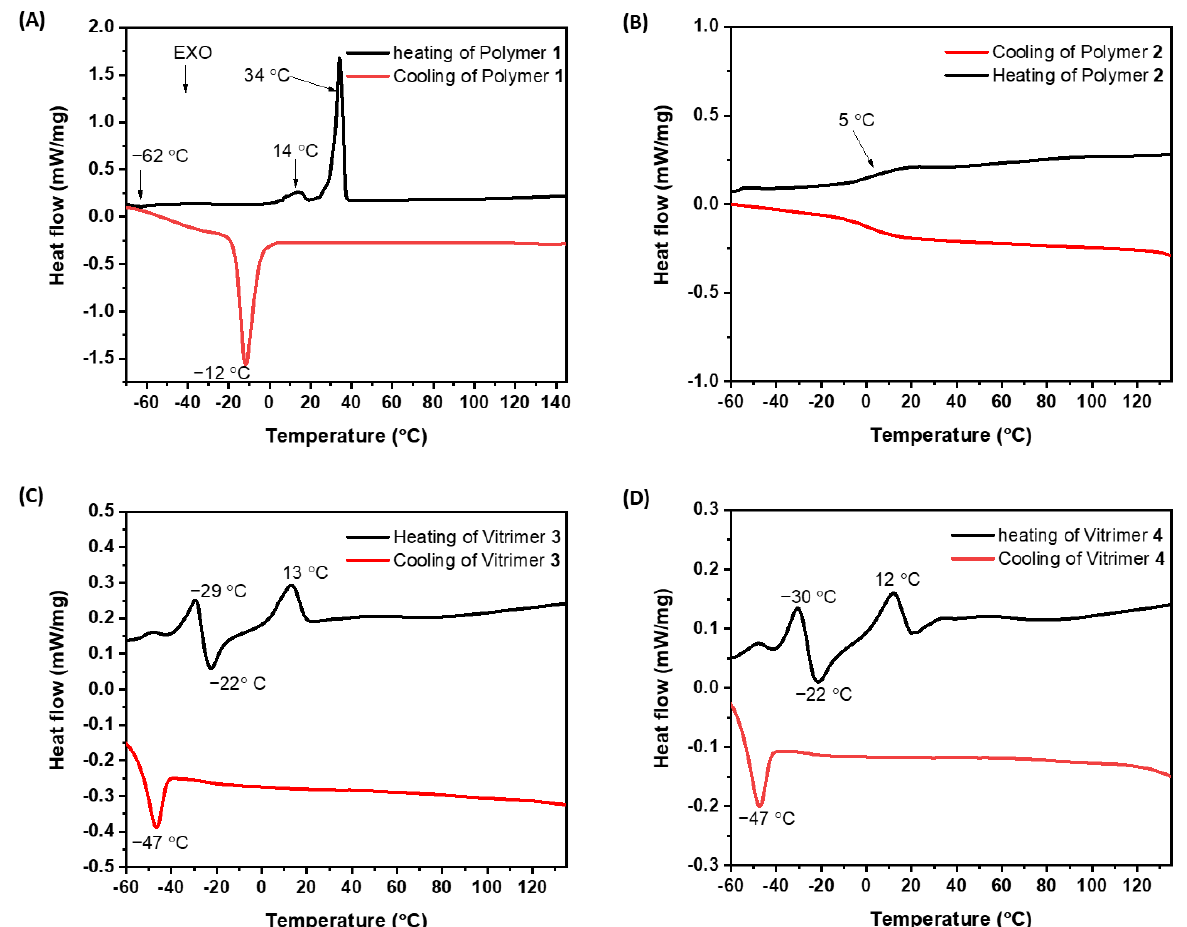
Figure 3. DSC profiles of the polymers 1 ( A ) and 2 ( B ) and the vitrimers 3 ( C ) and 4 ( D ) (temperature scan at a rate of 10 Kmin − 1 ).